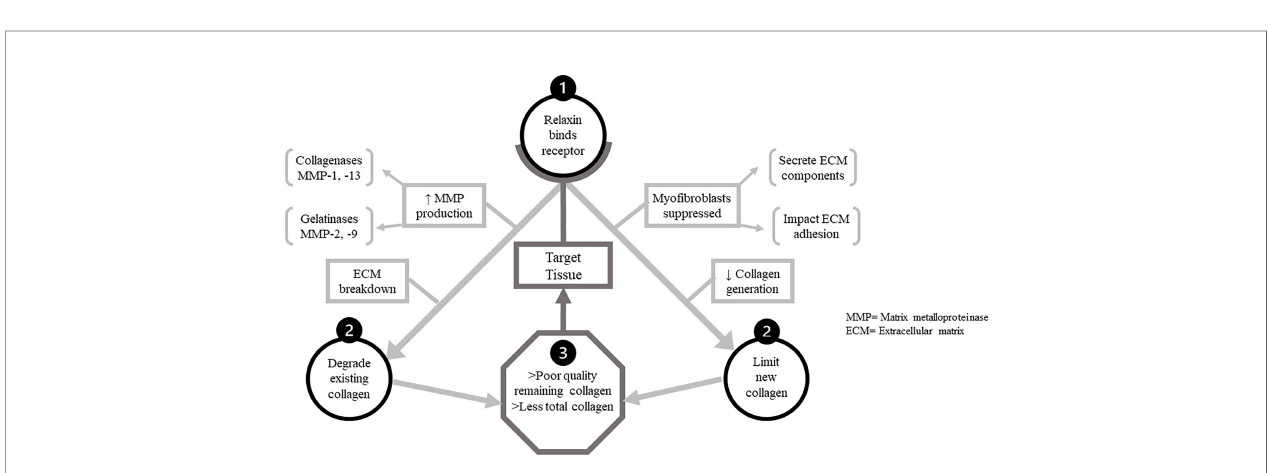
FIGURE 2 | The dual functions of relaxin in target tissues. The two main mechanistic pathways by which relaxin decreases tissue quality and quantity of collagen after binding to its receptor. Upon binding relaxin receptors in target tissue, two processes impacting collagen proceed concurrently. Above, left-relaxin increases production of all MMPs, but particularly the collagenases and gelatinases capable of digesting ECM components. Thus one mechanistic pathway detrimental to target tissue collagen is the degradation of existing collagen by these. MMPs. Above, right-relaxin also suppresses function of/differentiation into myo fi broblasts. These cell secrete multiple ECM components and modulate ECM cross-linkage, allowing relaxin to impair de novo collagen synthesis is target